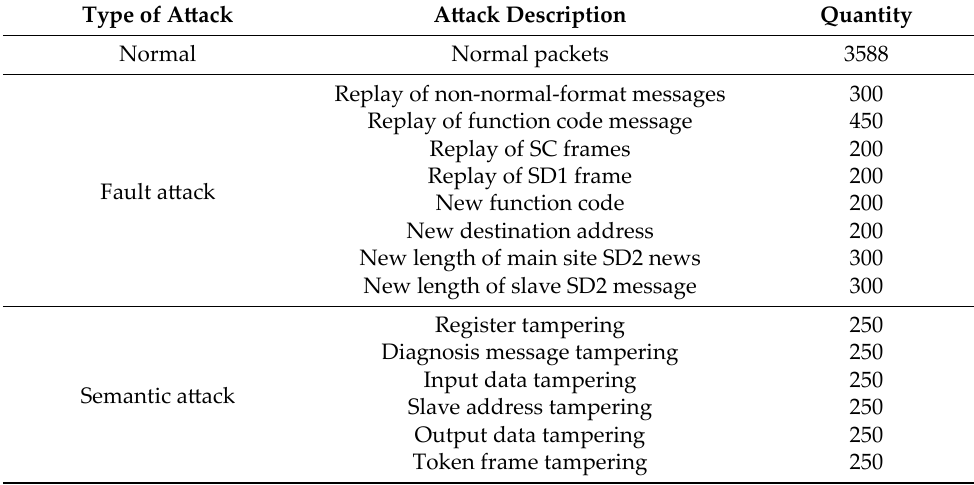
Table 3. Details of the generated experimental